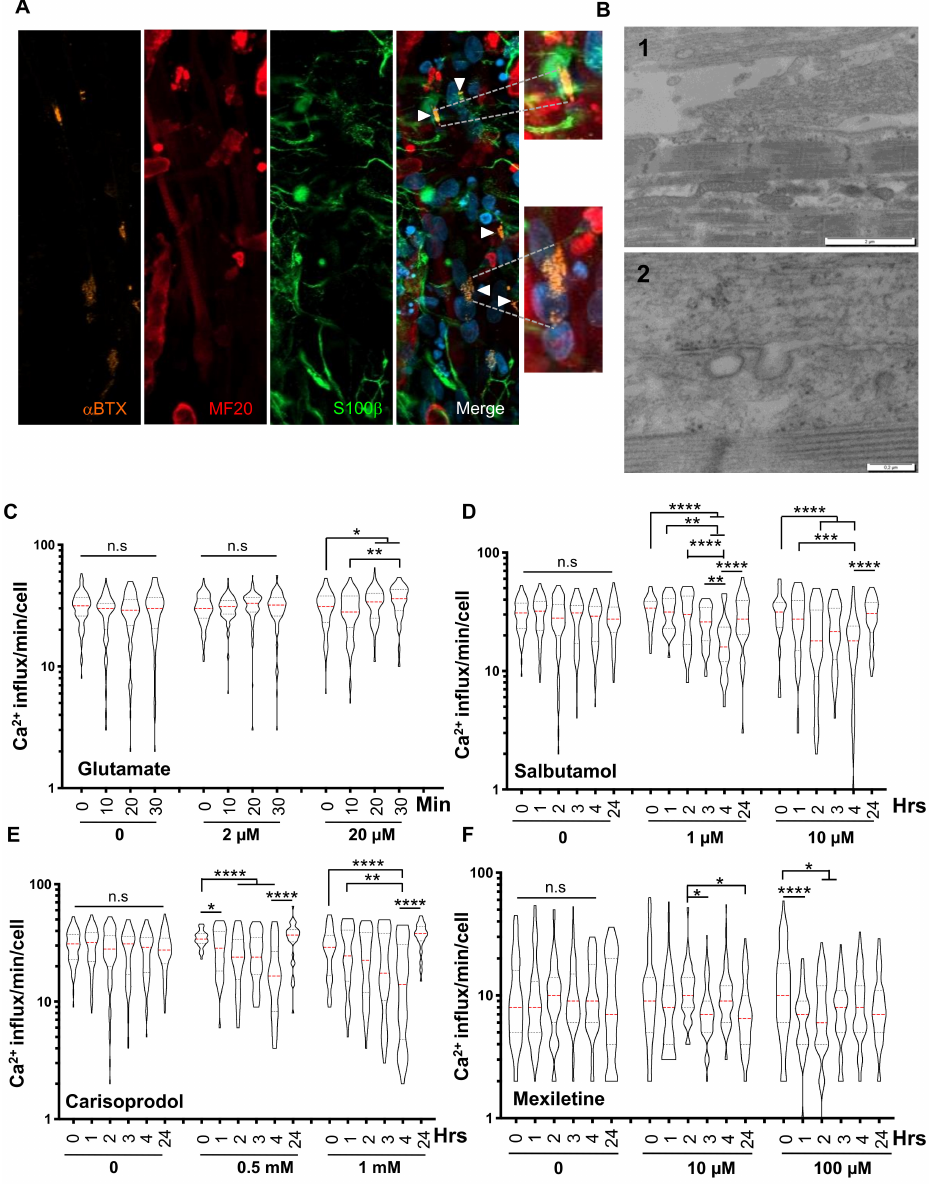
Figure 4. Characterization of NMJs and evaluation of the functional response to pharmaceutical drugs. ( A ) Representative Z stacks of cells stained at Day 30 postdi ff erentiation using alpha Bungarotoxin (aBTX, orange), anti-MyHC (MF20, red) or anti-S100 β (green). NMJs are indicated by white arrows on the merge. The formation of functional NMJs was confirmed by the presence of S100 β -positive cells expressed by Schwann cells capping the neuronal terminals. A higher magnification of di ff erent aBTX-positive NMJs is shown. ( B ) Transmission electron microscopy showing the presence of an axon positioned close to a muscle fiber. The basal lamina is visible (panels 1–2), as well as invagination of the plasma membrane (panel 2). ( C – F ) We measured the transient calcium influx in control myofibers prior to drug addition (0 h) and at di ff erent time points after a single addition of di ff erent concentrations of each drug. Violin plots display the number of influxes per minute and per fiber ( n > 50). Statistical significance was determined using an ANOVA multiple comparison test followed by Brown-Forsythe and Welch correction and comparison to the basal condition (prior to drug addition). C. 0; 2 and 20 µ M for glutamate after 0; 10; 20; 30 min of incubation, ( D ) 0; 1 and 10 µ M for Salbutamol after 0, 1, 2, 4 and 24 h of incubation. ( E ) 0, 0.5 and 1 mM for Carisoprodol after 0, 1, 2, 4 and 24 h of incubation. F. 0, 10 and 100 µ M for Mexiletine after 0, 1, 2, 4 and 24 h of